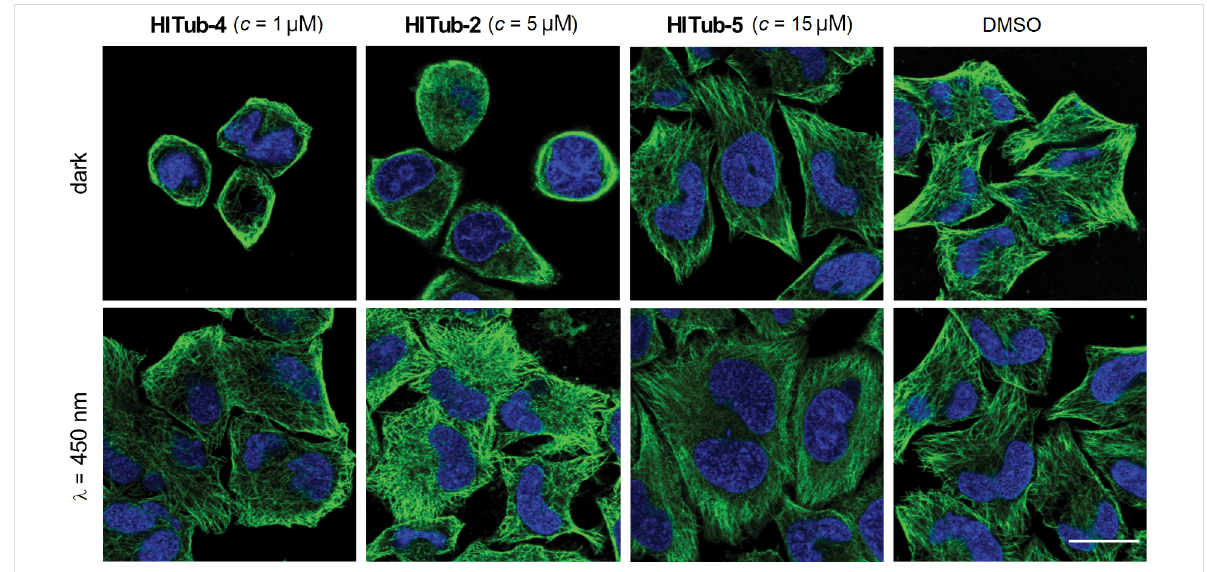
Figure 5: Confocal microscopy images of immunofluorescently labelled MT networks after treatment with HITubs for 24 h under lit ( λ = 450 nm) and dark conditions. HITub-4 and HITub-2 caused light-dependent MT disruption at low concentrations ( c = 1 and 5 μ M, respectively) matching their cyto- toxicities (EC 50 = 1 and 5 μ M, respectively). High concentrations of the structurally related negative control HITub-5 , like the DMSO co-solvent control, produced no effects under either illumination condition. MTs (anti- α -tubulin) are visualized in green while the nuclear stain 4 ′ ,6-diamidino-2- phenylindole (DAPI) is visualized in blue. Scale bar length = 20 μ